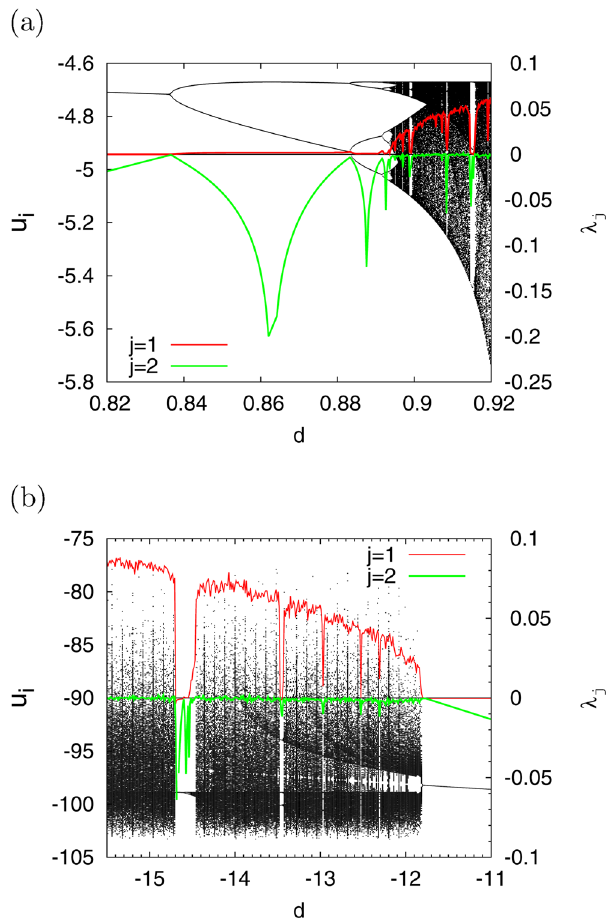
Figure 2. Bifurcation diagram of u i on Poincar é section Ψ and Lyapunov exponents λ j as function of parameter d ( j = 1, 2). ( a ) Period-doubling bifurcation case (called region #1) ( a = 0.02, b = 0.2, c = − 55, I = 10). The period-doubling bifurcation ( μ l = − 1) arises at d ≈ 0.8348, 0.8828, 0.8916, 0.894, and the chaotic state ( λ 1 > 0, = 0) appears d ≳ 0.894 through a period-doubling bifurcation route. ( b ) Tangent bifurcation case (called λ 2 region #2) ( a = 0.2, b = 2, c = − 56, I = − 99). The tangent bifurcation ( μ l = 1) arises at d ≈ − 11.9 and the chaotic state ( λ 1 > 0, λ 2 = 0) appears d ≲ − 11.9 through the intermittency